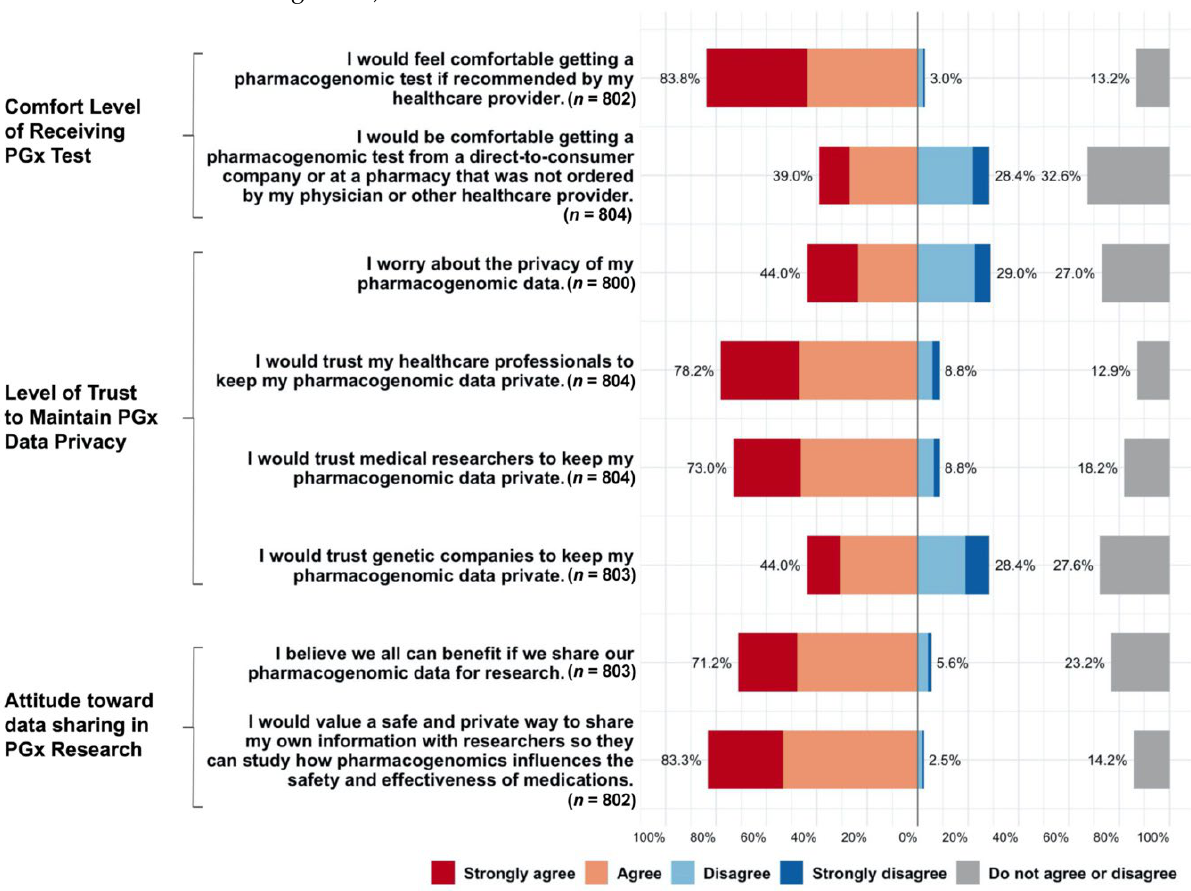
Figure 3. Acceptability of receiving pharmacogenomic (PGx) tests and attitudes toward data privacy and research among survey respondents.